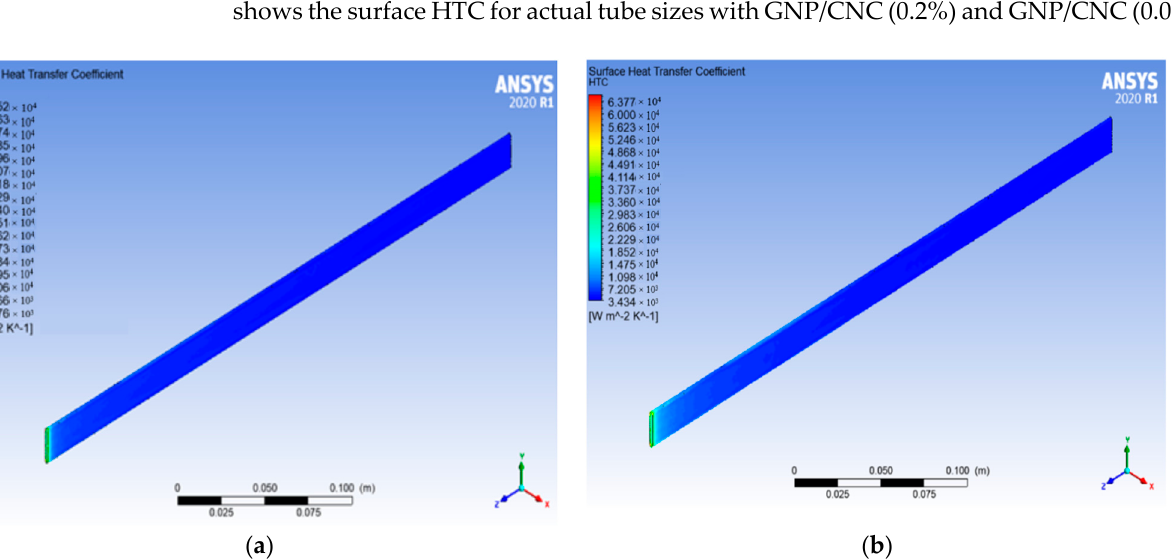
Figure 22. The pipe simulation at optimized size with G + CNC (0.01%). The surface HTC of an optimal tube size maintained with the hybrid nanofluid GNP/CNC at 0.01% volume concentration is 6661.21 W/m 2 K, which is close to the actual tube size with GNP/CNC at 0.2%, as seen in the above simulation image. With the opti- mized size of tube dimensions, the radiator may accomplish the Heat transfer coefficient value of actual tube size dimensions with a reduced volume concentration of hybrid nanofluid GNP/CNC at 0.01%, according to this simulation analysis by fluid flow. More space can be gained by shrinking radiator tubes, and greater heat transmission in the ra- diator can be attained with higher heat transfer coefficient values as nanoparticle concen- trations in the base fluid are extremely low in volume.